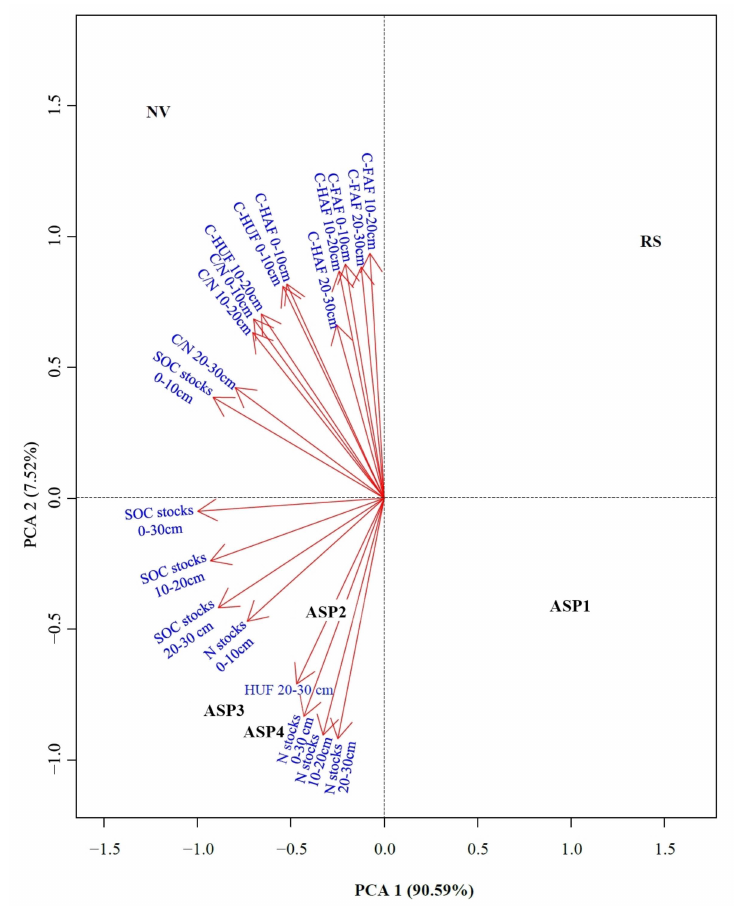
Figure 5. Relationship between principal components (PCA 1 and PCA 2) discriminating the land use and management systems according to the soil attributes at 0–10, 10–20, and 20–30 cm depth layers. Systems: E. camaldulensis × E. tereticornis hybrid intercropped with buffel grass using the arrangements 2 × 3 + 10 m (ASP1) and 2 × 3 + 15 m (ASP2); E. urophylla × E. grandis hybrid intercropped with buffel grass using the arrangements 2 × 3 + 10 m (ASP3) and 2 × 3 + 15 m